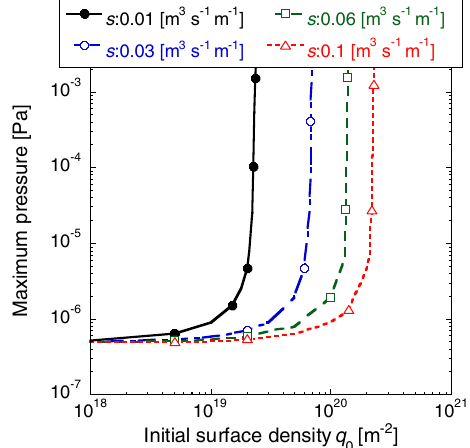
FIG. 21. Calculated dependence of the maximum pressure on the initial surface density of the adsorbed molecules for some pumping speed per unit length values. The beam power is fixed to 1 MW. The initial pressure is set to 5 × 10 − 7